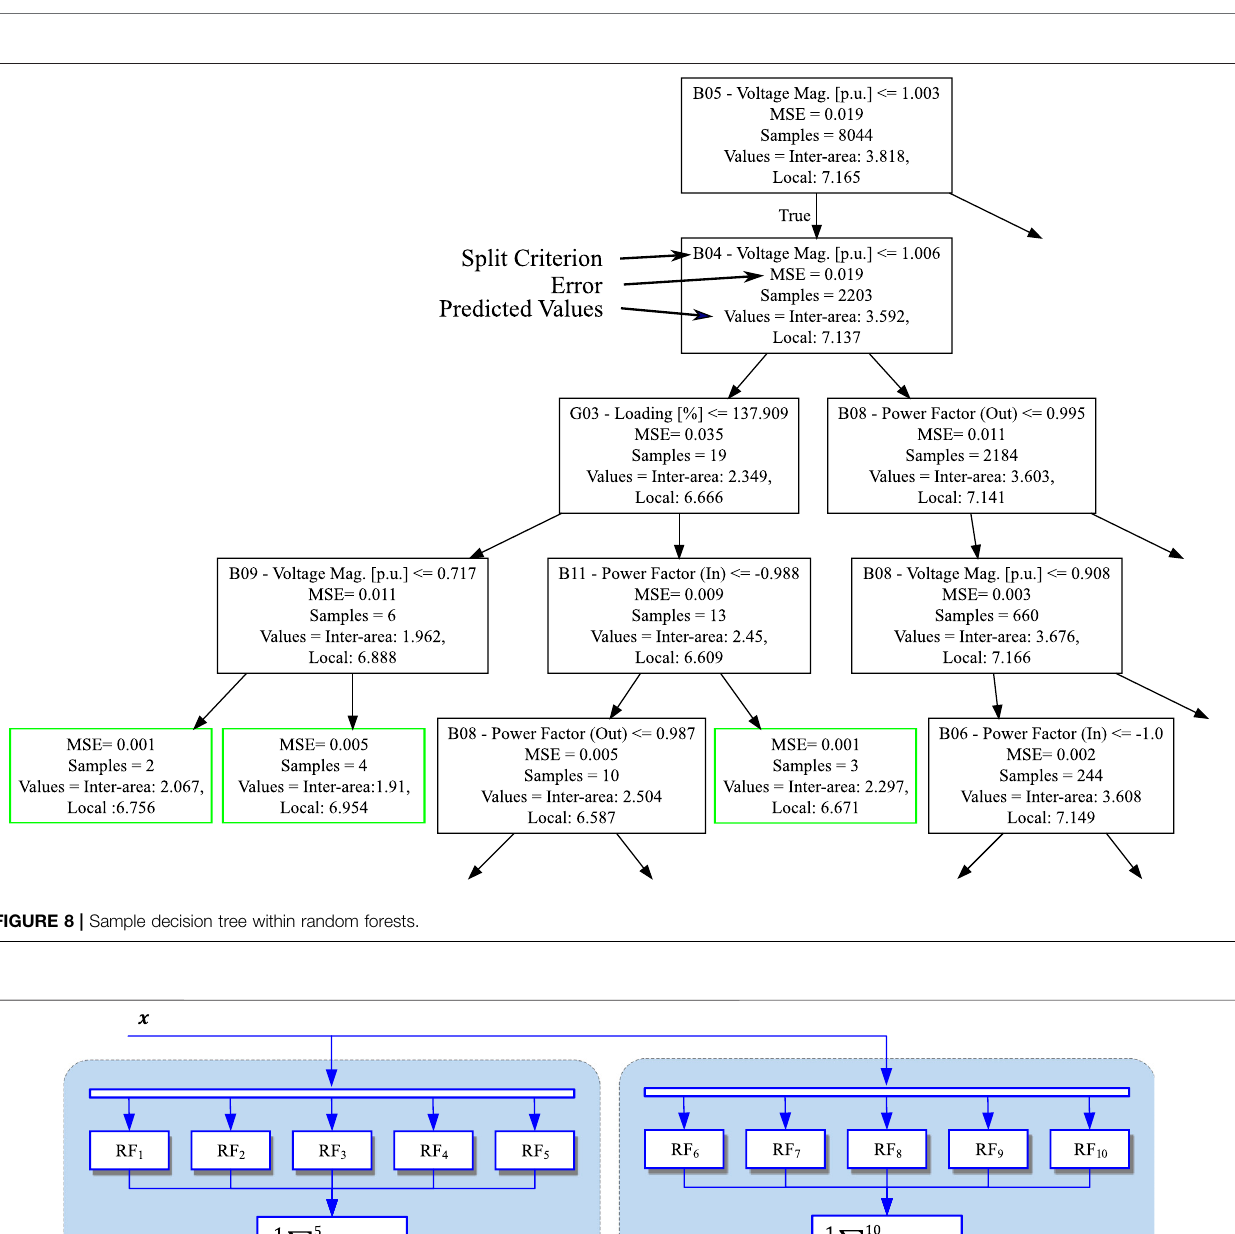
FIGURE 9 | Univariate structure of 5-fold cross validated Inter-area and Local mode frequency prediction.